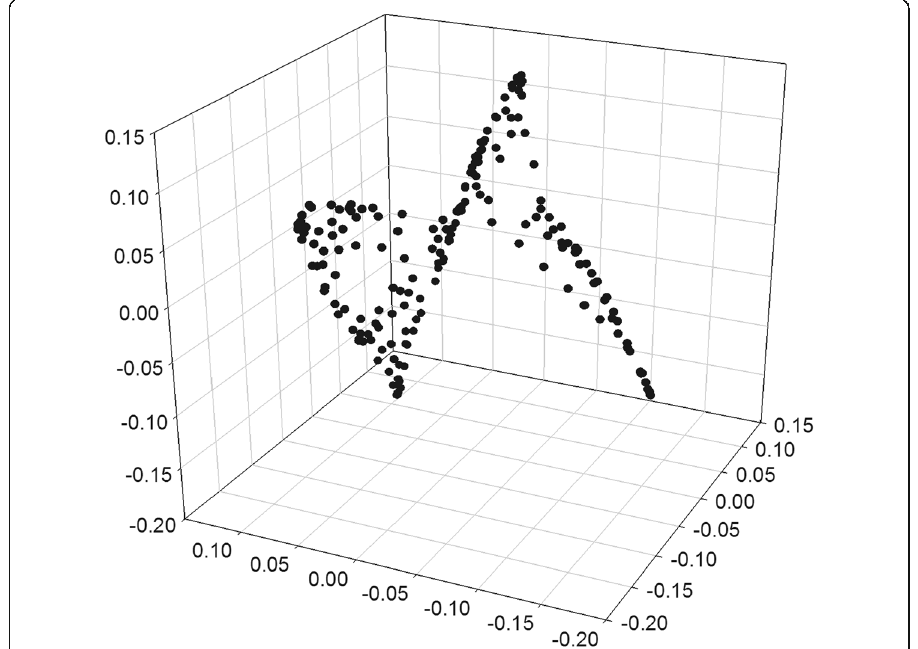
Fig. 2 Node coordinates in the eigenspace of the first 3 -smallest eigenvectors of the diameter-weighted graph L rw Laplacian